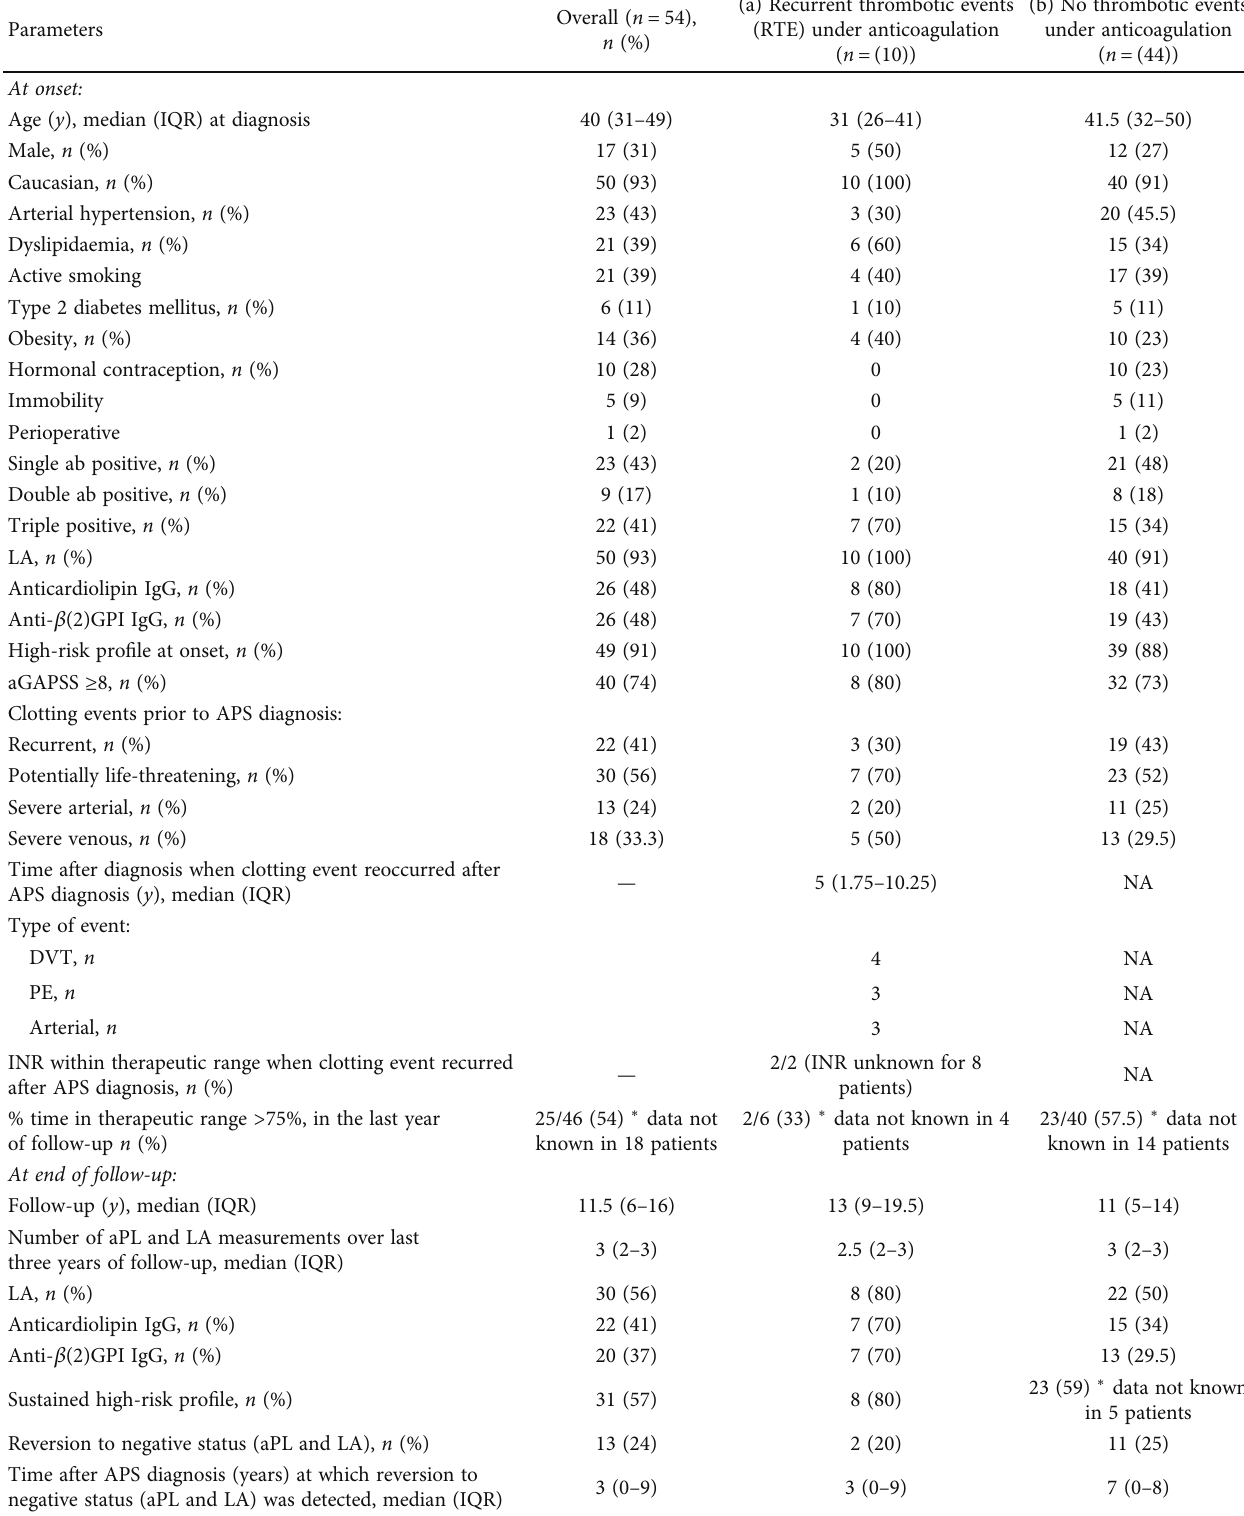
Table 1: Demographic, clinical, and laboratory parameters and risk pro fi le at onset and end of follow-up, represented as frequencies, according to the occurrence of repeated thrombotic events in patients under